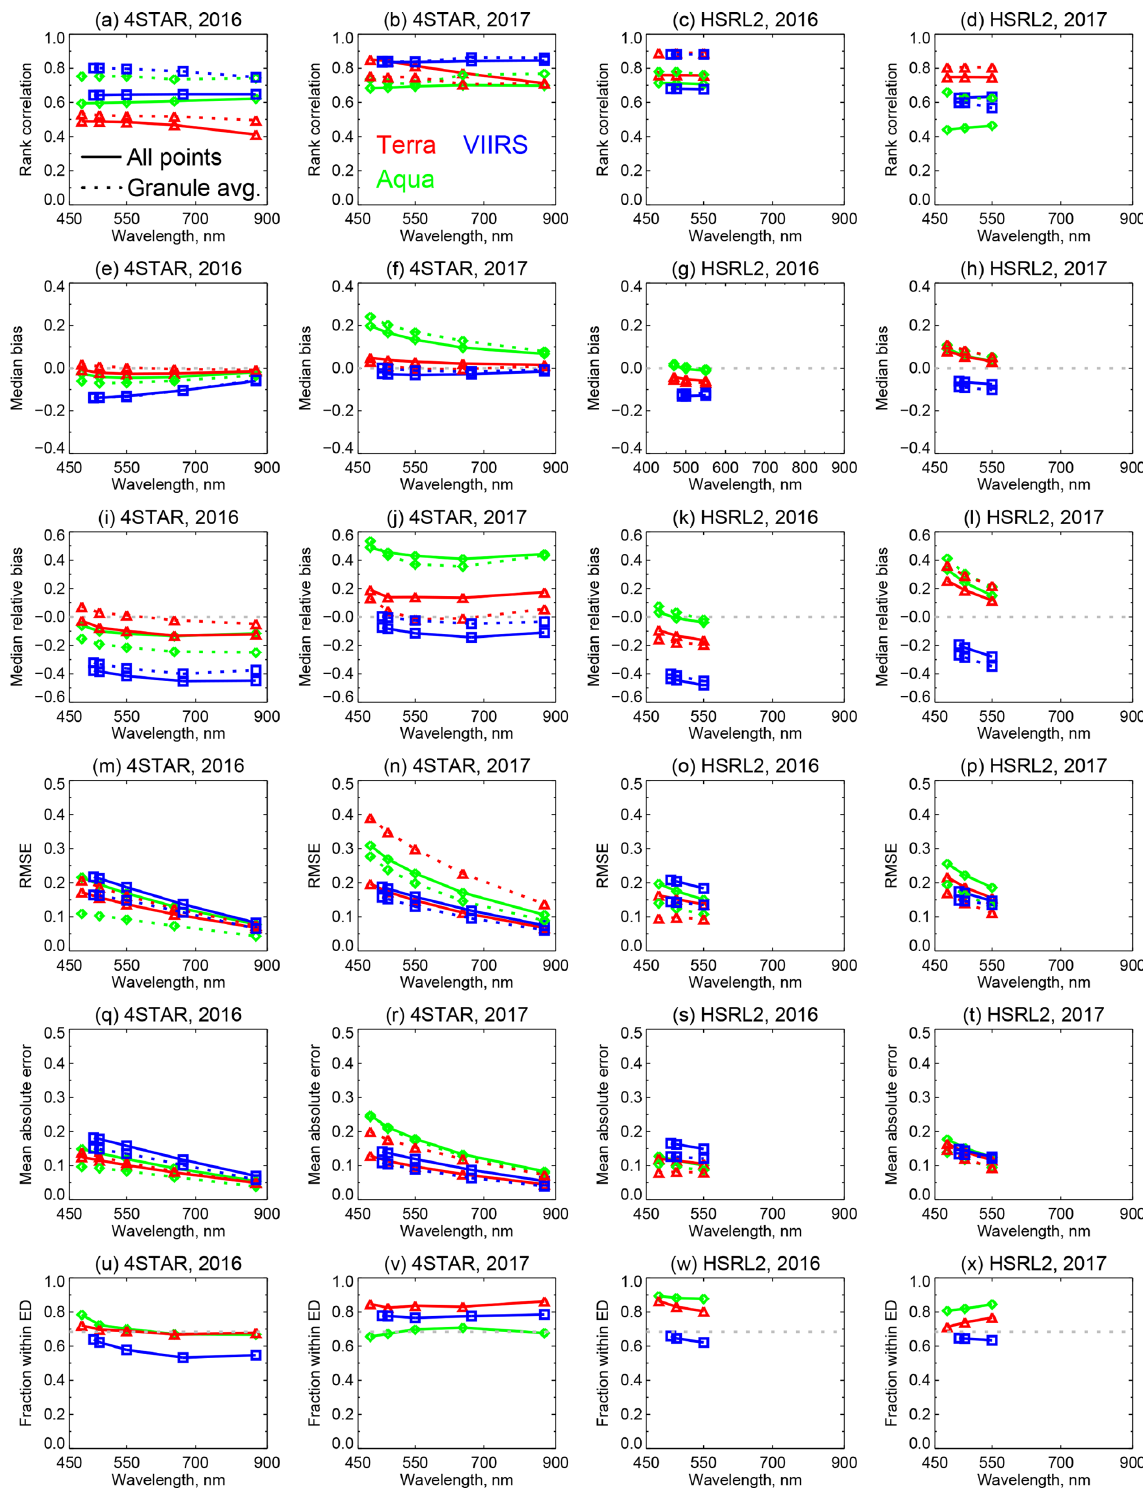
Figure 7. Summary line plots of spectral AOD validation statistics. Columns show (left to right) comparisons for 4STAR 2016, 4STAR 2017, HSRL2 2016, and HSRL2 2017. Rows show (top to bottom) rank correlation, median (satellite–airborne) bias, median relative bias, RMSE, MAE, and fraction f agreeing within the ED. In all panels, solid lines denote statistics for all matchups and dashed for granule-average comparisons. Data for MODIS Terra, MODIS Aqua, and VIIRS are shown in red triangles, green diamonds, and blue squares